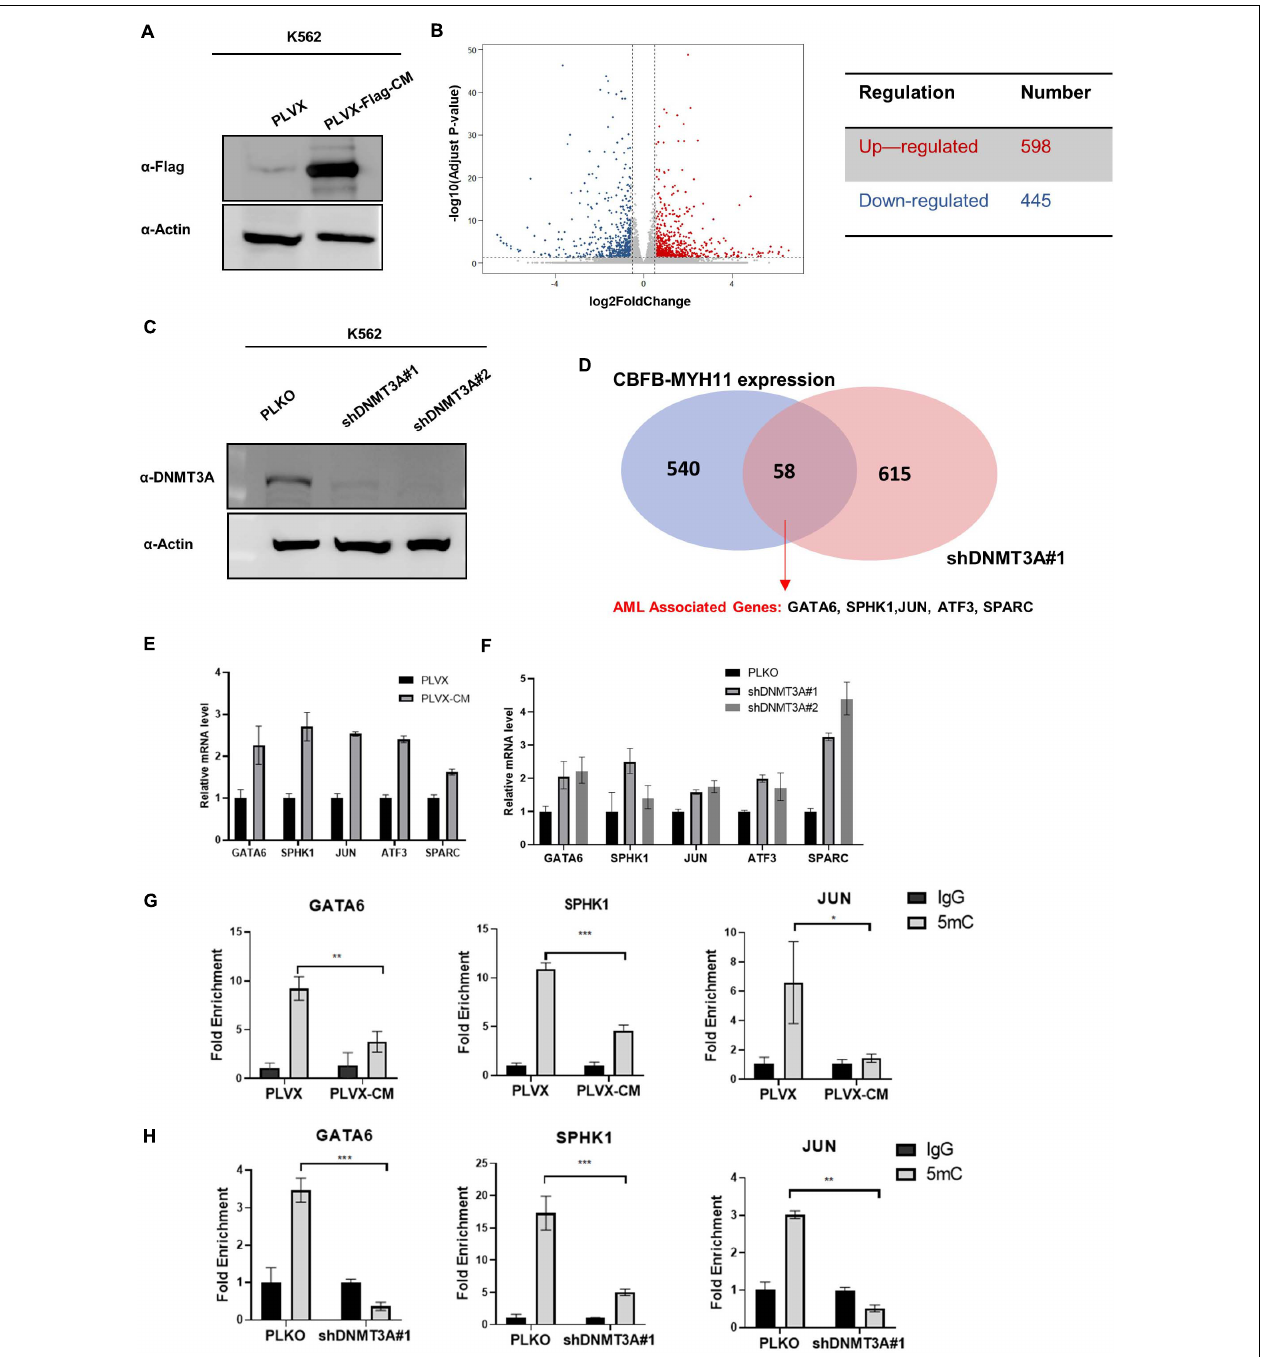
FIGURE 3 | CBFB-MYH11 expression or DNMT3A inhibition regulates a common set of target genes. (A) Expression of Flag-tagged CBFB-MYH11 fusion protein in K562 cells. K562 cells were infected with lentivirus expressing either empty pLVX vector or Flag-tagged CBFB-MYH11 fusion protein (pLVX-Flag-CM). (B) Volcano plot of the differentially expressed genes between CBFB-MYH11 expressing K562 cells vs. control cells. Significantly down-regulated genes are in dark blue (sig = True), while significantly up-regulated genes are in red (sig = True), non-significant genes are in gray (sig = False). Gray vertical lines highlight log fold changes of –0.585 and 0.585. (C) Validation of DNMT3A knocking-down in K562 cells. K562 cells were infected by lentivirus expressing empty pLKO vector or shRNA against DNMT3A . (D) Overlap of upregulated genes in K562 cells expressing CBFB-MYH11 fusion protein or with DNMT3A knocking-down identified by RNA-seq. (E,F) RT-PCR confirmed that AML associated genes were up-regulated in both CBFB-MYH11 expressing cells (E) and DNMT3A knocking-down cells (F) . Data were normalized by the mRNA expression level in control cells. (G,H) 5 mC level of GATA6, SPHK1, JUN in K562 cells were reduced by CBFB-MYH11 expression (H)